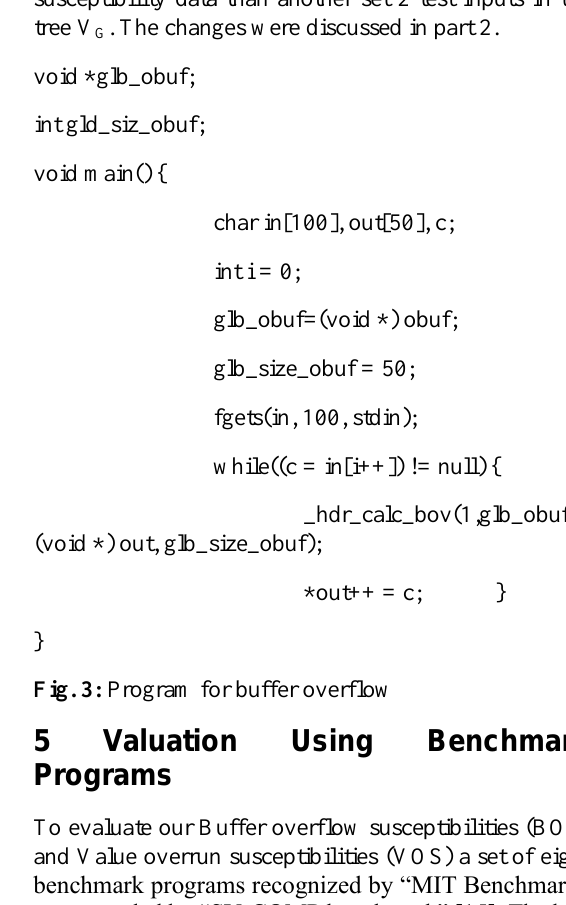
Fig. 3: Program for buffer overflow